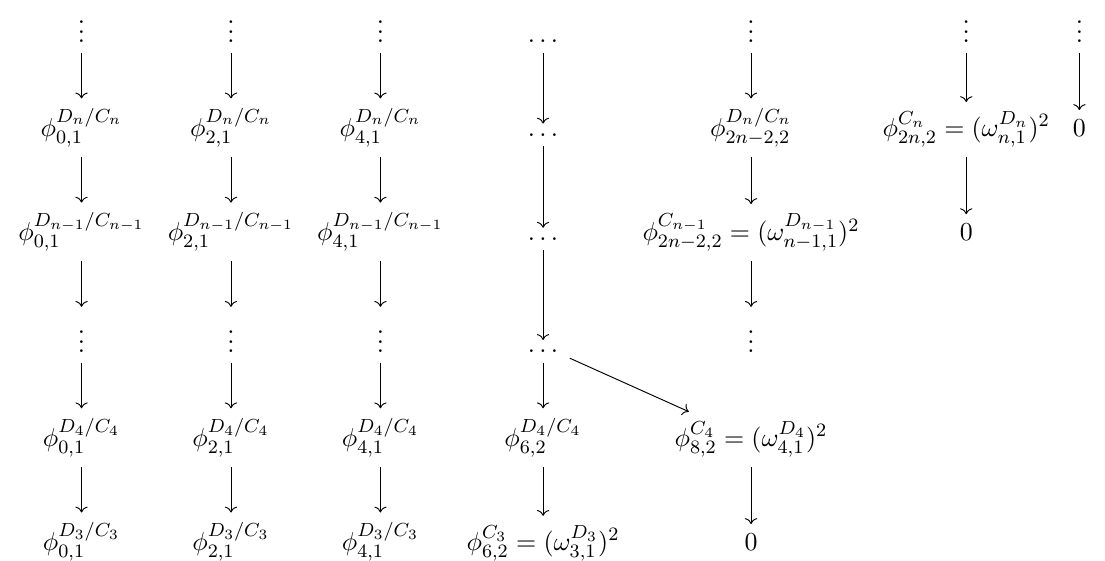
Figure 5 . Restriction of the D/C series Jacobi forms. The vertical arrows correspond to setting the last coordinate to 0 and multiplying by a constant (for C the same table as in